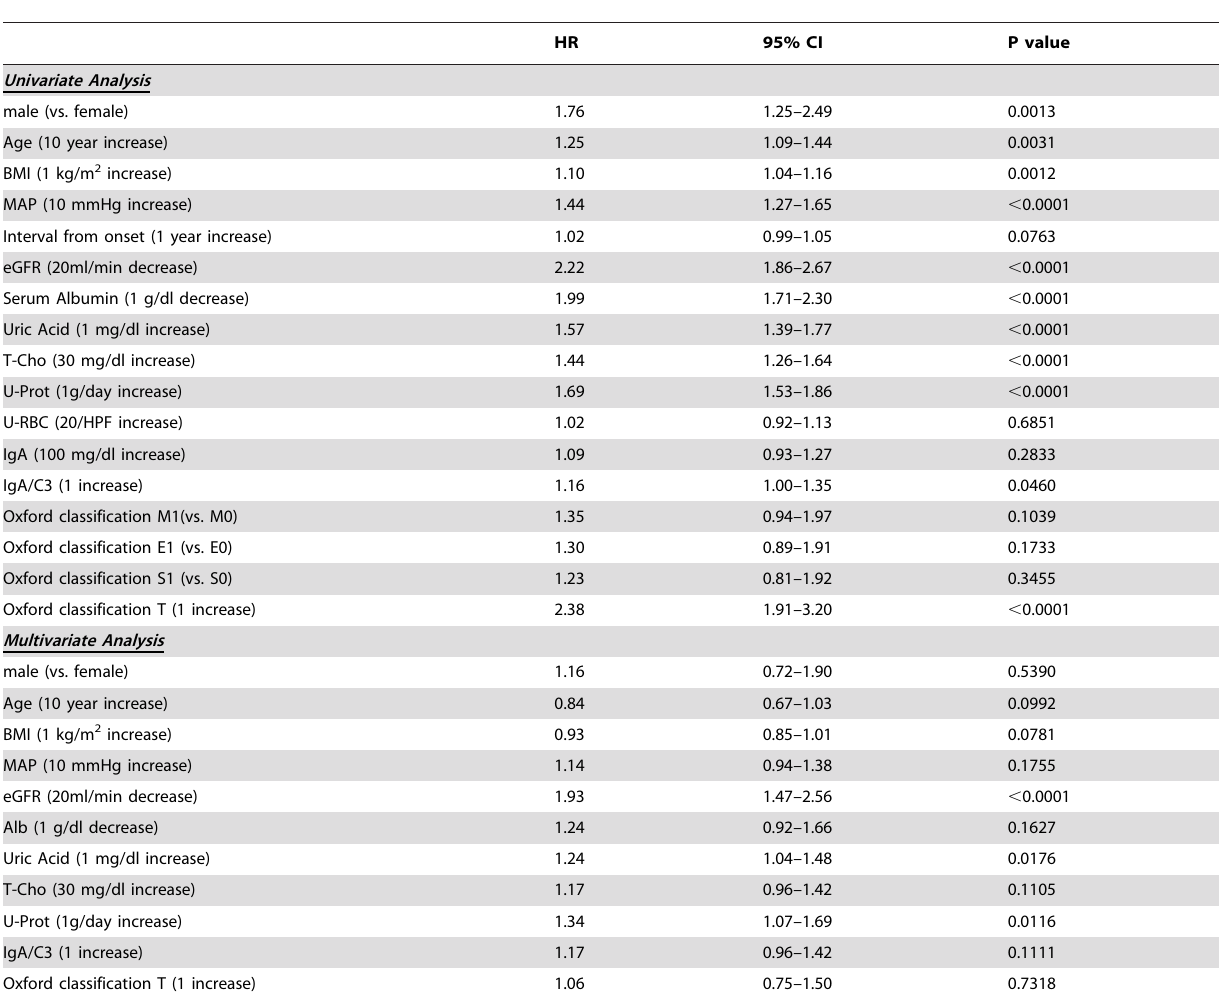
Table 4. Univariate and multivariate analysis of risk factors associated with ESRD in patients diagnosed with IgAN.